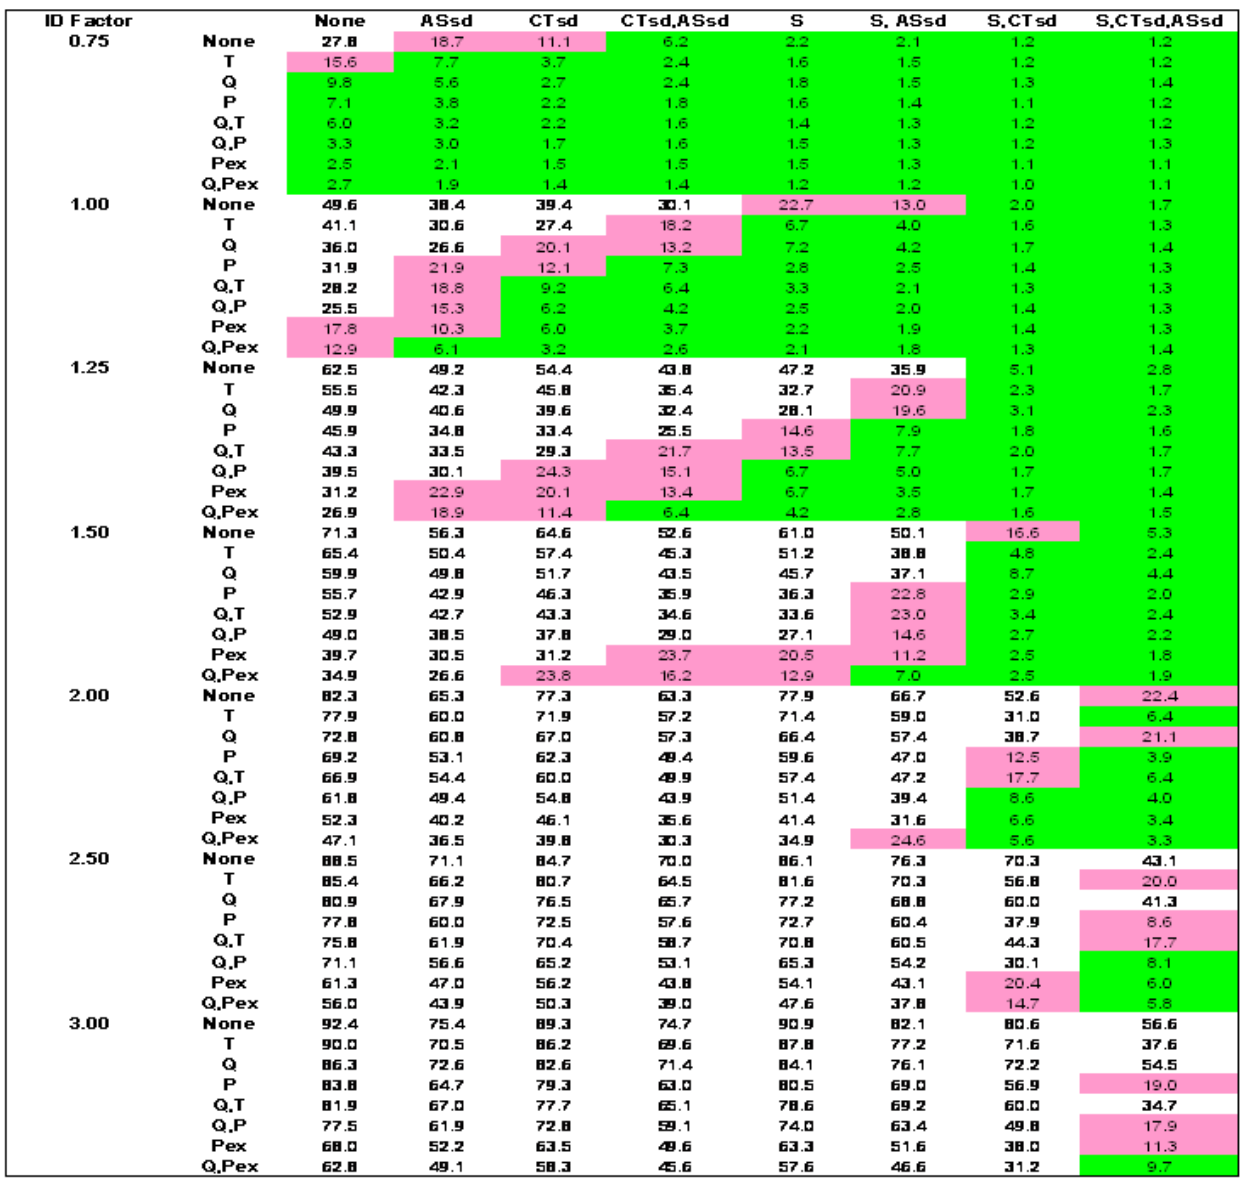
Figure 1. Percentage of population infected. S=schools closed; CTsd=child/teenager social distancing; ASsd=adult/senior socials distancing; Q=household quarantine; T=antiviral treatment; P=antiviral prophylaxis of household members; PEx=extended antiviral prophylaxis. For Ferguson-like disease manifestation and implementation threshold when 10 cases are diagnosed. Case-based interventions are applied directly to or around diagnosed individuals to limit transmission and are: Q, T, P, and PEx. Network-based interventions are applied to affect links and contacts between individuals throughout the entire network and are: S, CTsd, ASsd (where adults continue to attend work, although at a 50% reduction in contacts at the workplace). Case-based interventions vertical; network-based interventions horizontal. Green shading denotes infection rates # 10 percent of population. Pink shading denotes infection rates between 10 and 25 percent.